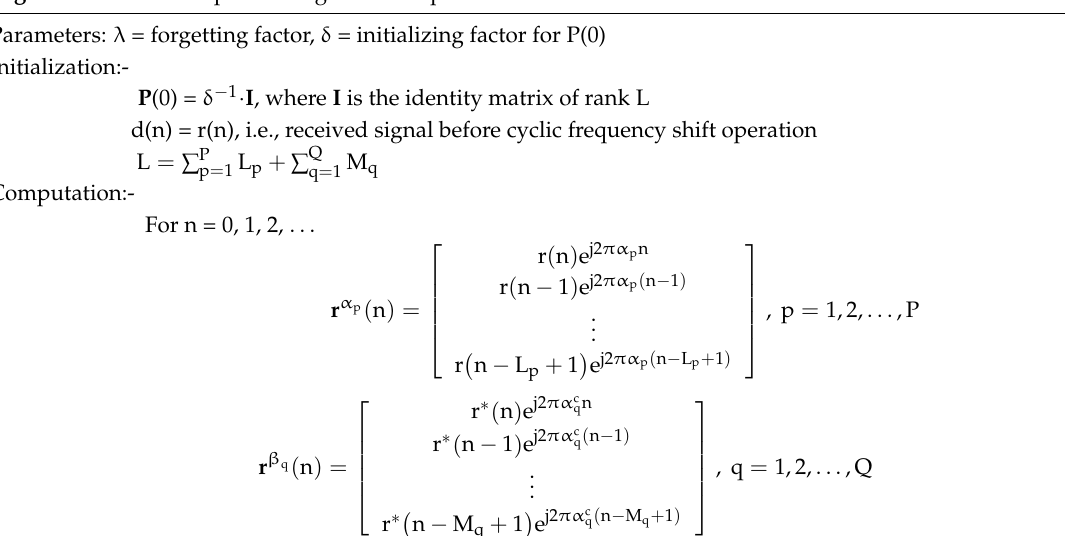
Algorithm 1. RLS Adaptation Algorithm